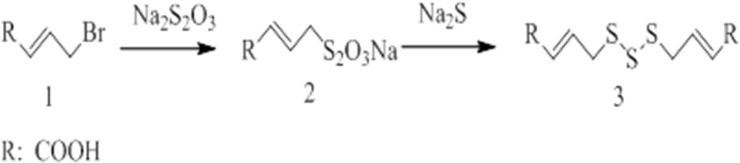
Routes for synthes of TSDB.